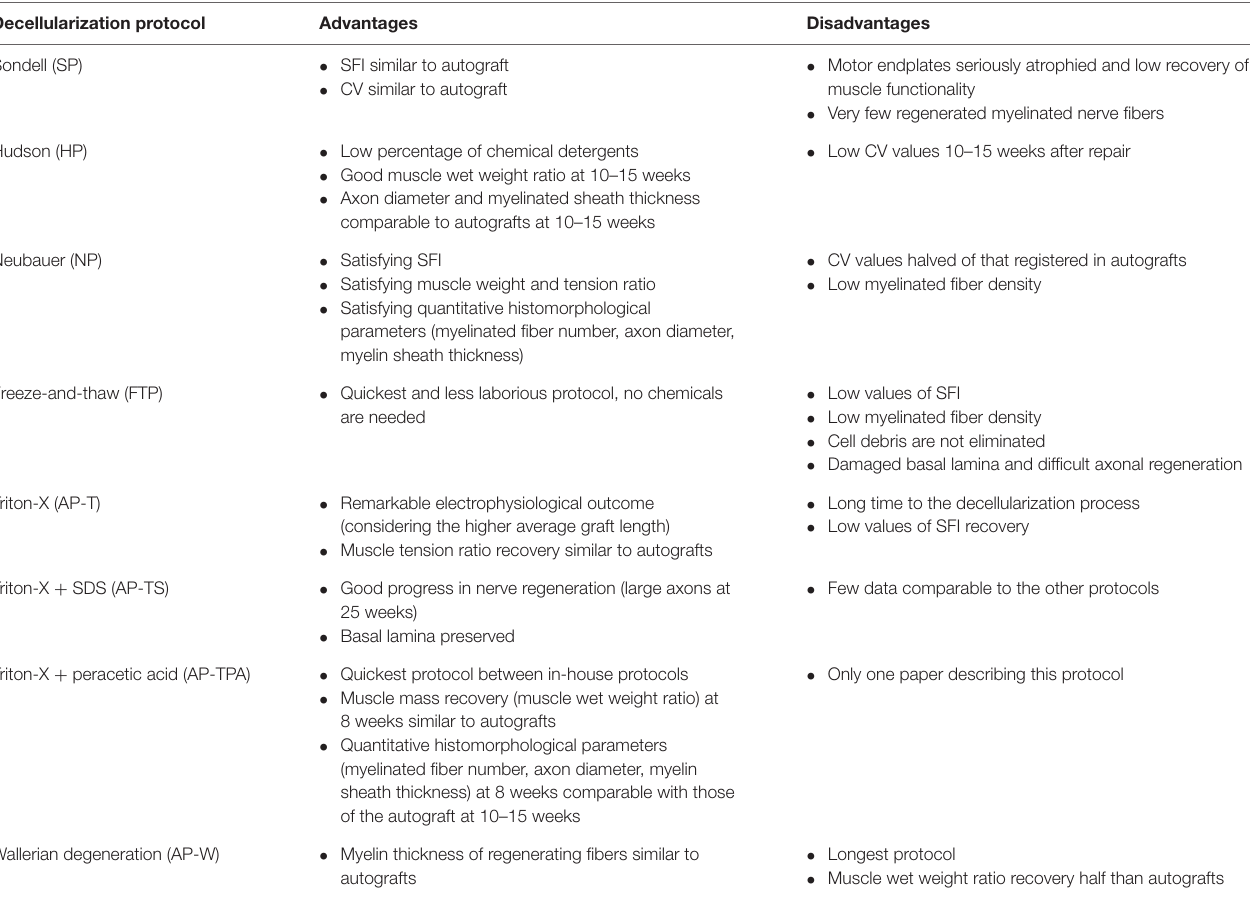
TABLE 7 | Advantages and disadvantages of the various protocols to decellularize nerve